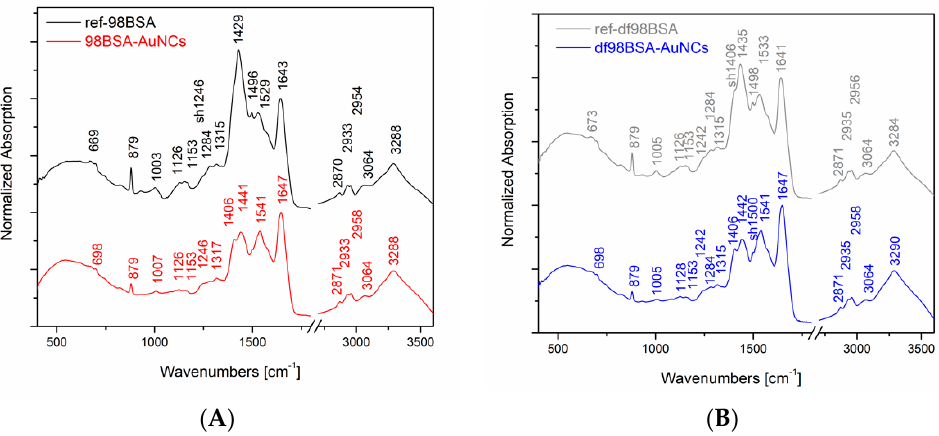
Figure 2. Normalized IR absorption spectra (to the band at around 1643 ± 4 cm − 1 ) of AuNCs prepared by using either ( A ) 98BSA or ( B ) df98BSA. Reference IR spectra of the same type of BSA treated by the same manner as that applied in the AuNCs synthesis, however without the addition of HAuCl 4 , are shown for the sake of a direct comparison.